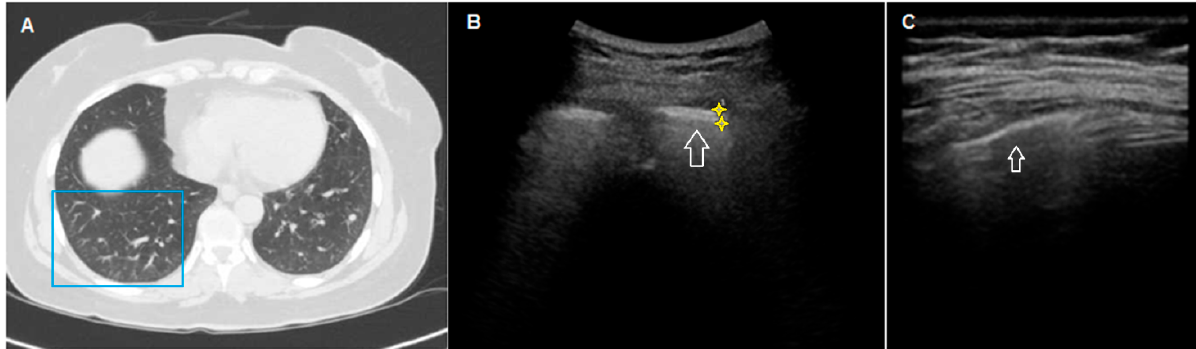
Figure 2. TUS images of the hyperechoic pleural line in a patient with an HRCT pattern of Usual Interstitial Pneumonia (UIP). ( A ) The hyperechoic pleural line (white arrow) appears thickened (5.1 mm) when measured with a middle/low ‐ frequency convex probe (3.5–5 MHz). ( B ) The thick ‐